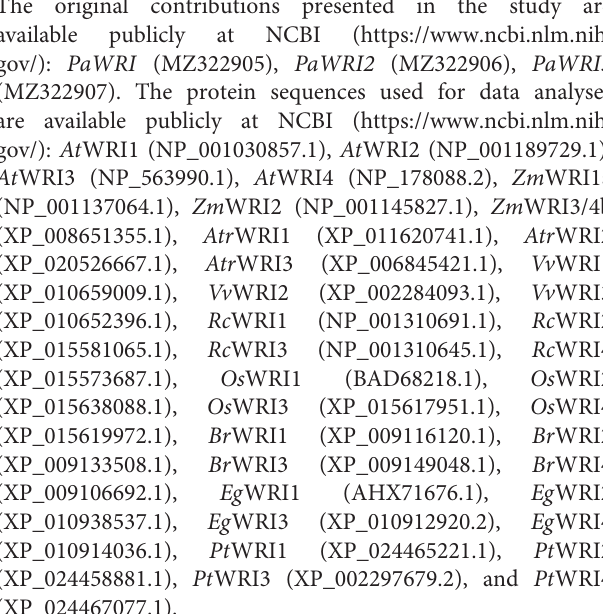
Supplementary Figure 1 | Phylogenetic analysis and percentage identity among WRI1 homologs . (A) Phylogenetic analysis of WRI1 homologs in Arabidopsis thaliana (At) , Zea mays (Zm) , Amborella trichopoda (Atr) , Populus trichocarpa (Pt) , Ricinus communis (Rc) , Brassica rapa (Br) , Elaeis guineensis (Eg) , Vitis vinifera (Vv) , Oryza sativa (Os) and Persea americana (Pa) was carried out using UPGMA method (see Supplementary Table 1 ). An AP2-domain transcription factor from Chlamydomonas reinhardtii ( Cr AP2) was used as outgroup. Percentages indicate bootstrap values for 1000 replicates. The WRI-orthologs are shown in color; WRI1 (black), WRI2 (pink), WRI3 (orange), WRI4 (blue). (B) Percentage of amino acid sequence identity among the WRI1 homologs from avocado ( Pa ), Arabidopsis ( At ), and maize ( Zm ). Supplementary Figure 2 | Sequence alignment of WRI1, WRI2, and WRI3 from various species showing conserved amino acids. Multiple sequence alignment of primary sequences of WRI1, 2, and 3 from species as described in Supplementary Figure 1 are shown in a color-coded format; red and blue colors represent the most (10, indicated by asterisk) and least (0) conserved regions, respectively on a scale of 0 to 10. Positions of the AP2 domains are shown as pink color bars under the sequences and the amino acid residues in the AP2 domain important for DNA interaction are represented by ( (cid:78) ). Supplementary Figure 3 | Multiple sequence alignment of WRI1 homologs from the select three species. The alignment shows KIN10 target sites (red box) in the WRI1 homologs with reference to T70 and S166 identified in At WRI1. The S166 residue is mutated in At WRI2 and Zm WRI2. The highlighted amino acid residues correspond to the PEST motifs. Supplementary Figure 4 | Amino acid composition profile of WRI1 homologs. Amino acid composition profile of WRI1 homologs showing the enriched and depleted amino acids as compared to SwissProt51 database. The amino acids are arranged in the increasing order of hydrophobic character on the x -axis and the y -axis represents the composition profile. The values > 0 represents an enrichment and < 0 represents a depletion of corresponding amino acids in the protein sequence. The significantly ( p < 0.05) enriched (green) and depleted (blue) residues are denoted in color. Supplementary Figure 5 | Graphical representation of the predicted IDRs. The predicted IDRs in all the WRI homologs are graphically plotted with the amino acid position on the x -axis and the PONDR score on the y -axis. Regions showing PONDR score > 0.5 are considered as IDRs. For Atr WRI1 and Atr WRI2, although the figures are not showing the PONDR score, the predicted IDRs by the same software are as follows: 30-53, 137-160, 234-348 for WRI1 and 12-84, 168-190 for WRI2. Both of them have the C -terminal IDR. Supplementary Table 1 | List of online tools used for various predictive structural analysis of WRI1 orthologs.